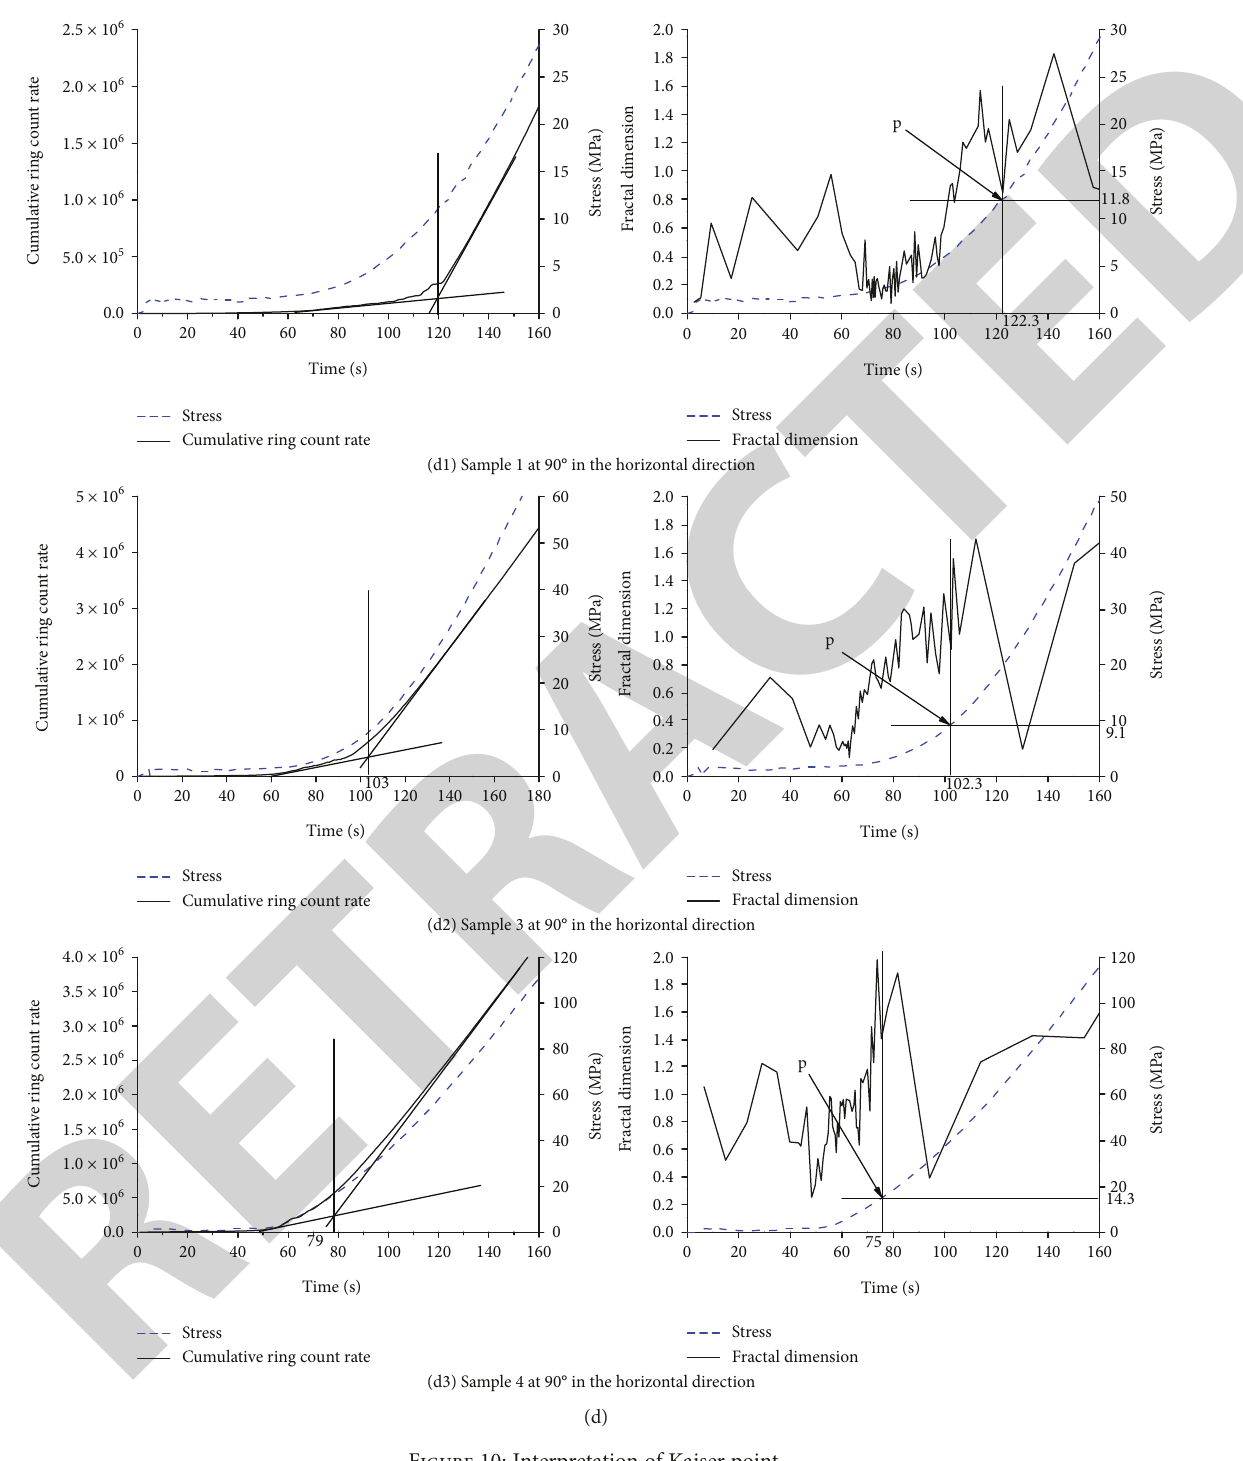
Figure 10: Interpretation of Kaiser